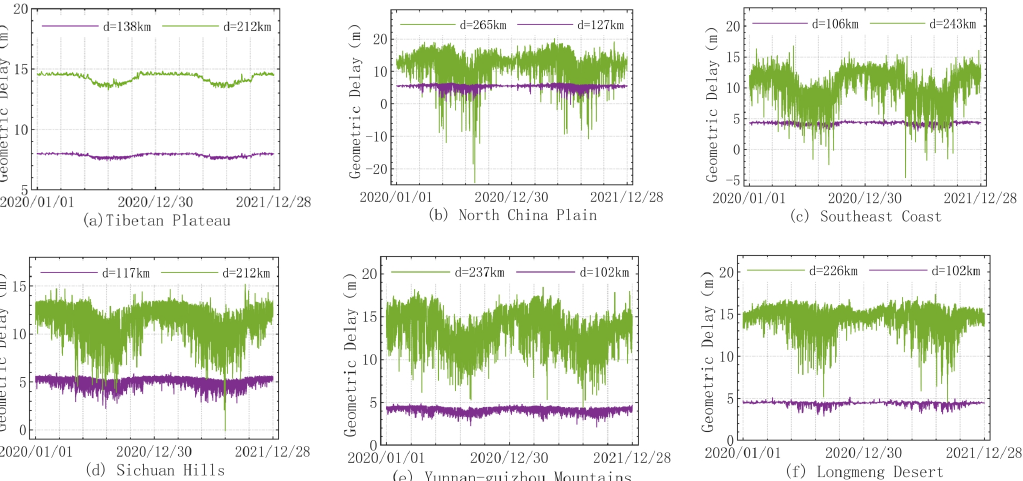
Figure 5. Sca tt ered propagation path delays for 12 links. These six sub fi gures show the path delay of 12 links in di ff erent regions: ( a ) Tibetan Plateau, ( b ) North China Plain, ( c ) Southeast Coast, ( d ) Sichuan Hills, ( e ) Yunnan–guizhou Mountains, ( f ) Longmeng Desert.